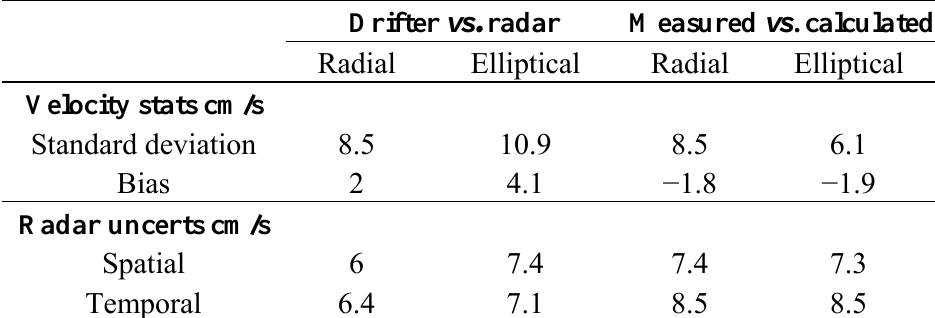
Table 1. Comparison